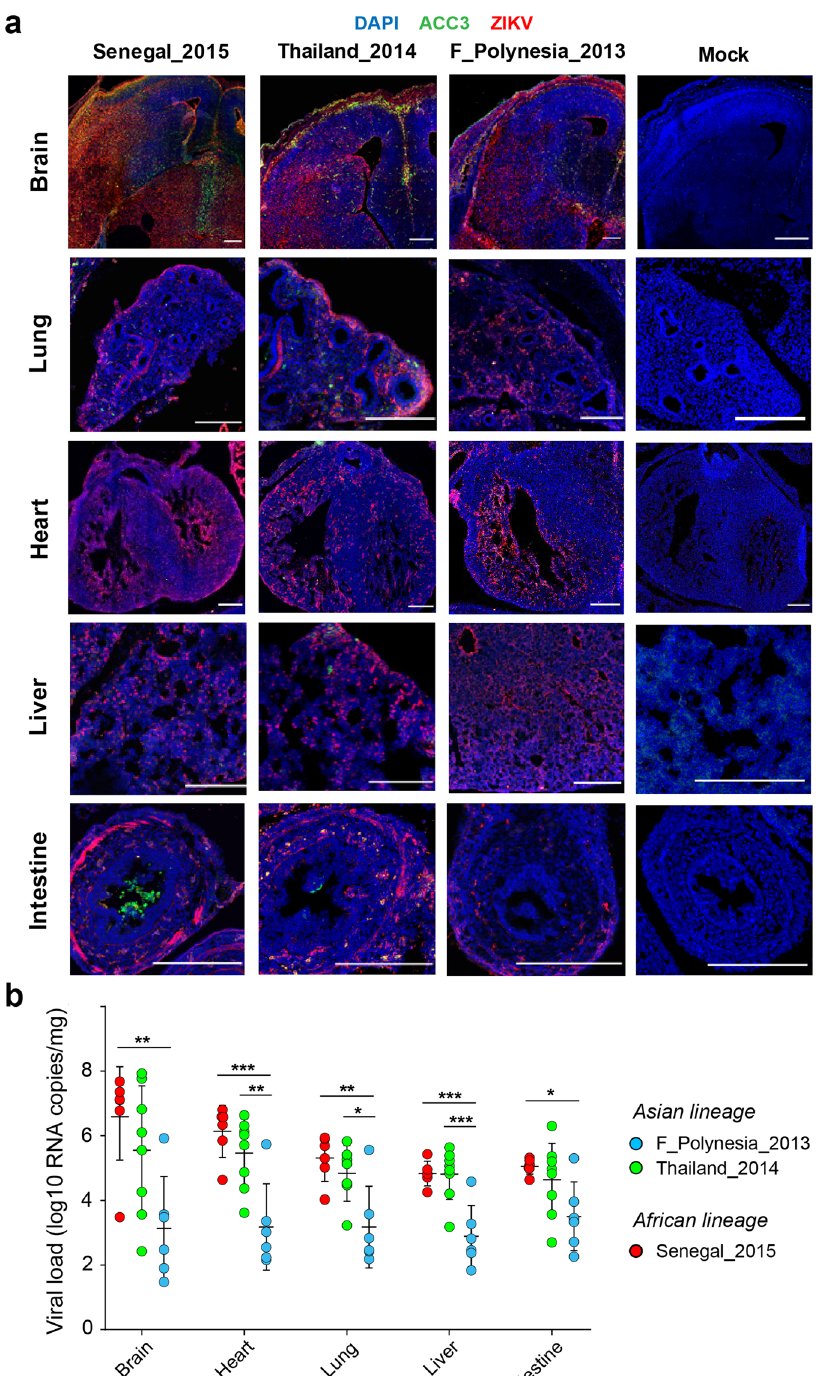
Fig. 5 Organ tropism and viral load of African and Asian strains of ZIKV in vertically infected mouse embryos. Immunocompetent mouse embryos were infected at E10.5 by intraplacental injection of 500 – 1000 PFU of ZIKV and analyzed at E14.5 by microdissection. a Immunolabeling of embryonic brain, lung, heart, liver and intestine sections representative of each ZIKV strain tested ( n = 3 embryos per strain). Blue, green and red colors indicate DAPI, anti- cleaved caspase 3 (ACC3) and ZIKV stainings, respectively. The scale bars represent 200 µ m. b Viral load of embryonic brain, lung, heart, liver and intestine are shown for each ZIKV strain in viral genome copies per organ. Data are presented as mean ± standard deviation and represent n = 6 mice for the Senegal_2015 and F_Polynesia_2013 strains and n = 8 mice for the Thailand_2014 strain. Statistical signi fi cance of the differences was determined by one-way ANOVA followed by Tukey ’ s post hoc test and is only shown when signi fi cant (*** p < 0.001; ** p < 0.01; * p < 0.05). Viral loads differed signi fi cantly between ZIKV strains ( p < 0.0277) in all organs. Source data are provided as a Source Data fi